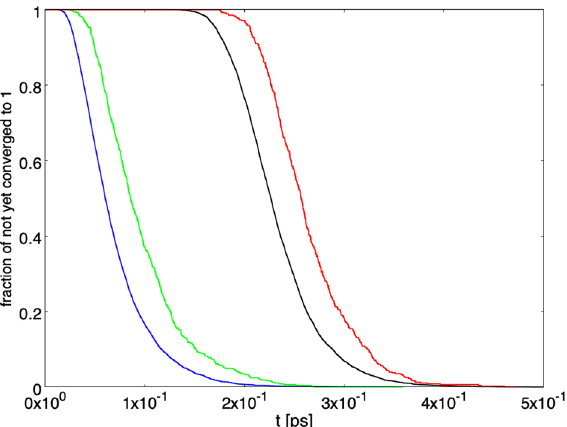
2 ≤ 1 − 𝜀 as a function of time, for c R | |